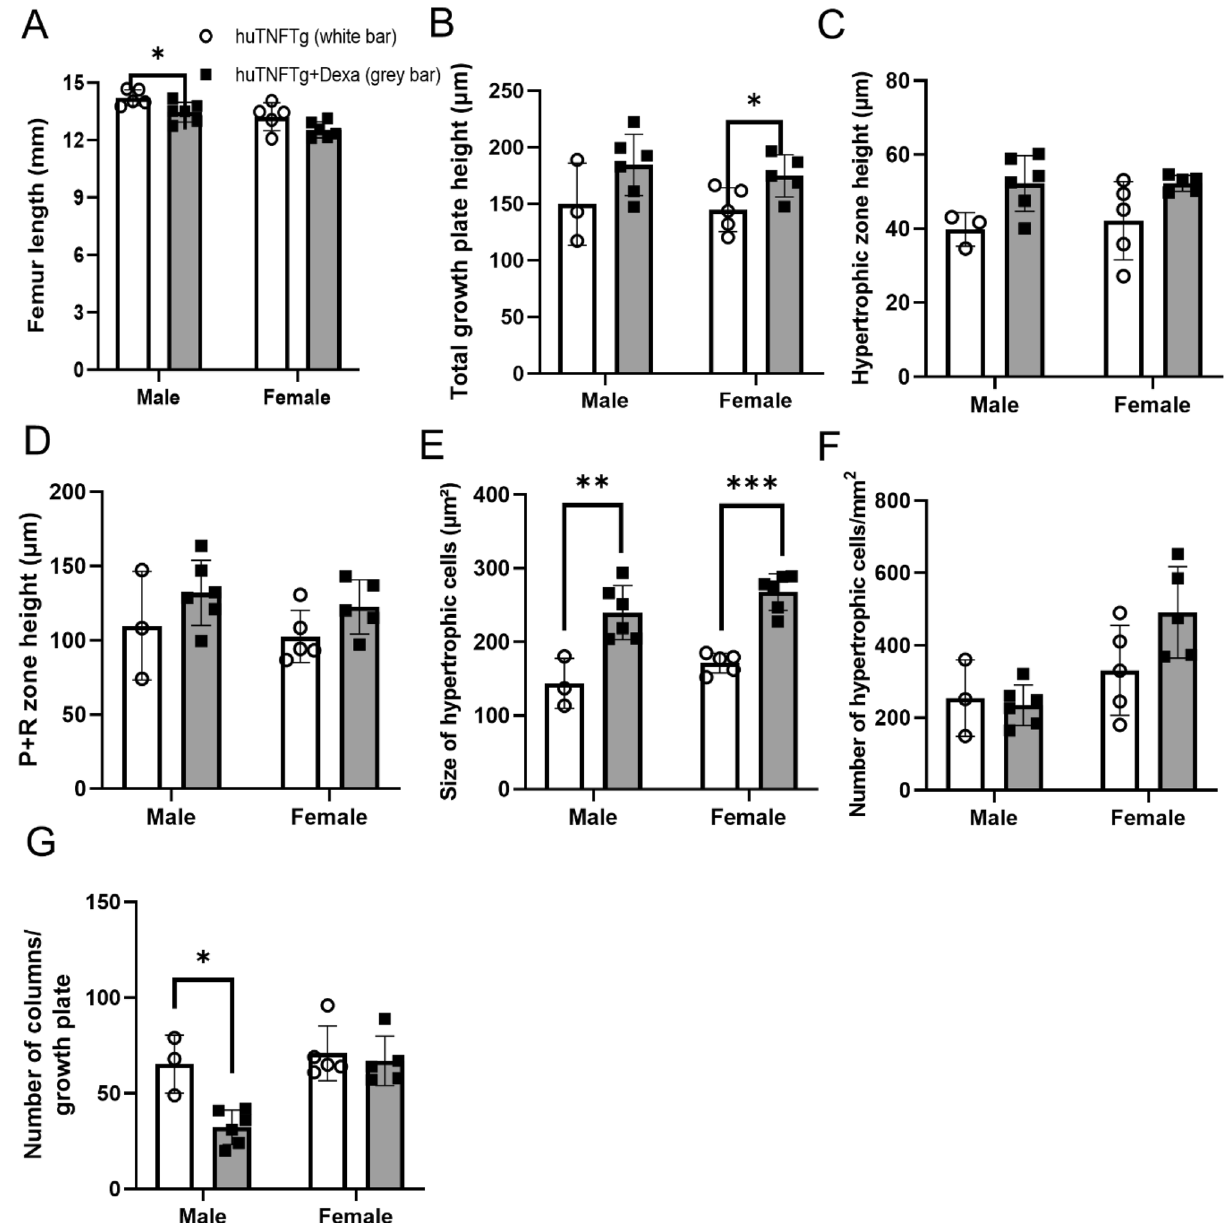
Figure 5. Effects of Dexamethasone (Dexa) treatment on bone growth and chondrogenesis in male and female huTNFTg mice. ( A ) Femur length measured by digital caliper (n = 5–6). ( B ) Total growth plate height, ( C ) height of the hypertrophic zone, and ( D ) height of the resting + proliferative (R + P) zone in femur growth plates in each group. ( E ) Measurements of the size of hypertrophic cells in femur growth plates in each group. ( F ) Analysis of number of hypertrophic cells per growth plate ( G ) and number of columns per growth plate in each group (n = 3–6). Error bars indicate mean ± SD. Students t-test was used to analyze difference between groups. * p < 0.05, ** p < 0.01, *** p <